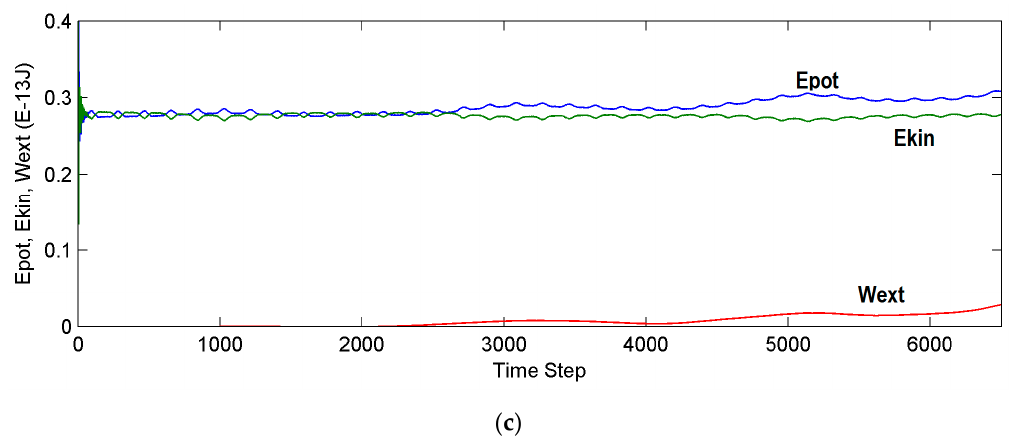
Figure 1. ( a ) Scheme of the heated (yellow) atomistic sample from [6], B denotes the sample thickness; ( b ) global energy balance in MD during the heating (time step <1000) and gradual loading (time step >1000) with biaxiality ratio α = σ B / σ A = 0.0 at the temperature of 300 K; ( c ) at 600 K.